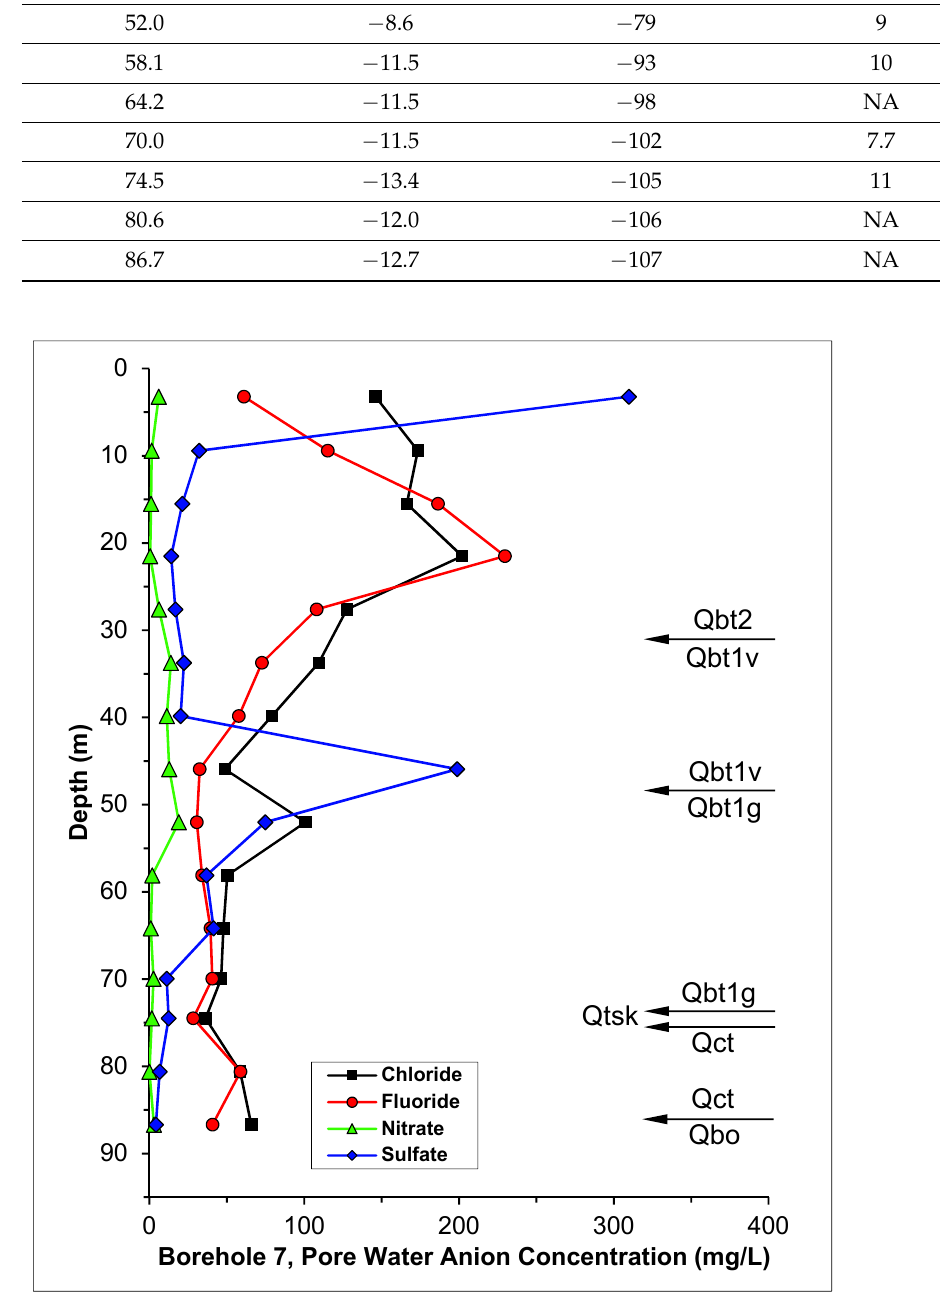
Figure 4. Pore watepr chloride, fluoride, nitrate, and sulfate concentrations in Borehole 7, TA-53. Stratigraphic contacts are shown on the right side of the figure.